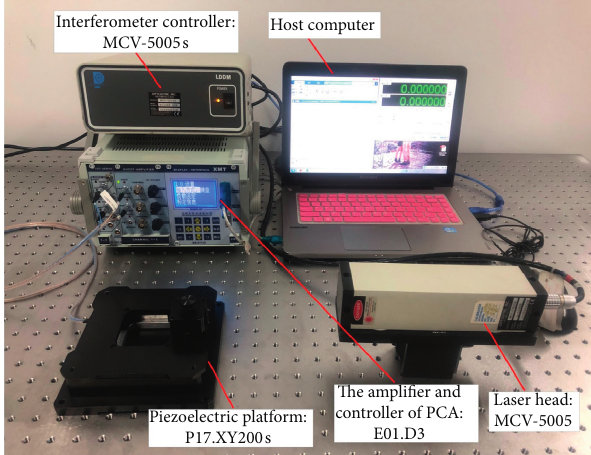
Figure 9: Experimental setup.